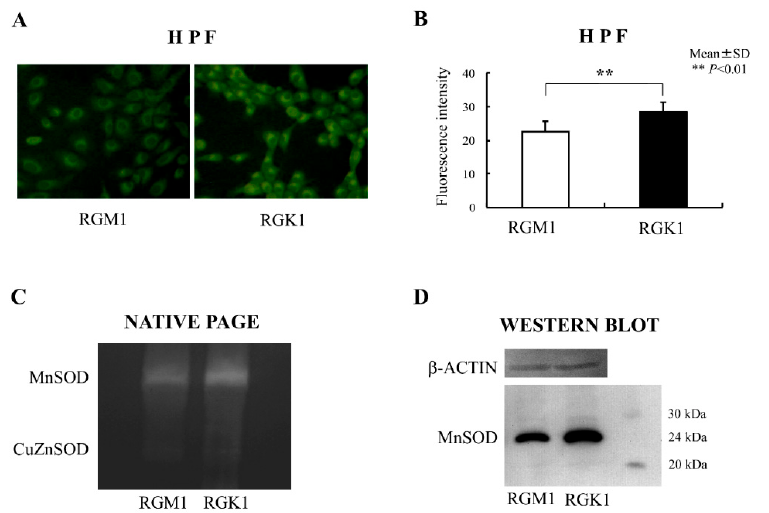
Figure 2. Reactive oxygen species (ROS) and MnSOD expression and activity in RGM1 and RGK1 cell lines. ( A ) Laser confocal images of cells treated with the ROS-reactive dye, HPF. HPF was loaded in RGM1 and RGK1 cells for 15 min, and the fluorescence was observed using a laser confocal microscope. Magnification 20 × . ( B ) Semiquantitative fluorescent detection of ROS in the presence of HPF. The fluorescence intensity was significantly higher in RGK1 cells than in RGM1 cells. Bar: mean ± S.D.; t -test. **: p < 0.01. ( C ) SOD activity in RGM1 and RGK1 cells was analyzed by staining a native polyacrylamide gel. Each lane was loaded with 20 µ g of protein and electrophoresed through the native polyacrylamide gel at 4 ◦ C. Both activities in both cell lines were clearly detectable. The MnSOD activity of RGK1 cells was greater than that of RGM1 cells activity. ( D ) Expression of MnSOD protein was detected using Western blot analysis. Each lane was loaded with 20 µ g of protein and electrophoresed on a 12% polyacrylamide gel at 4 ◦ C. The protein levels of RGK1 cells increased compared with those in RGM1 cells (Redrawn from [50] with permission ).